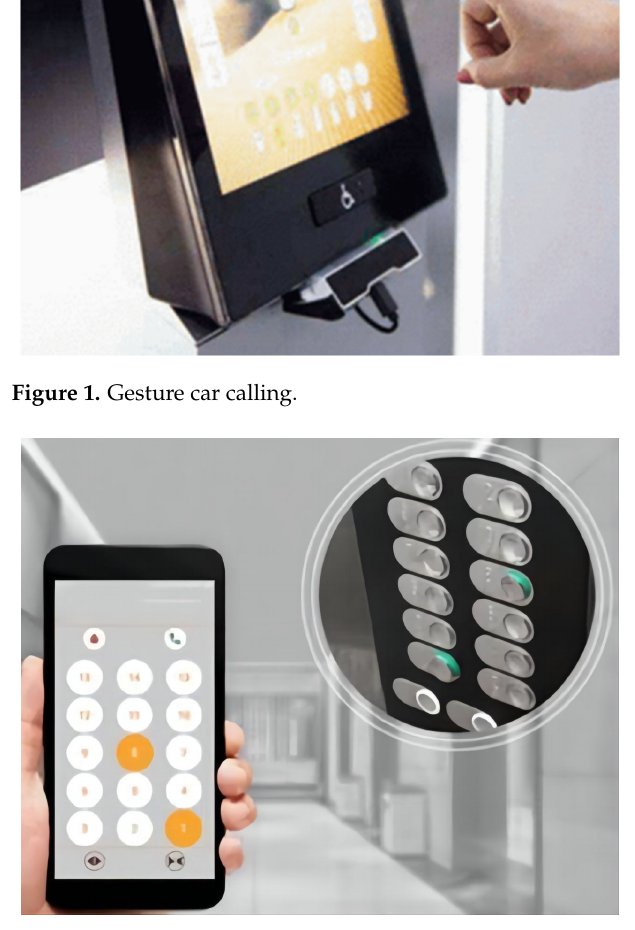
Figure 2. Mobile phone call floor App.